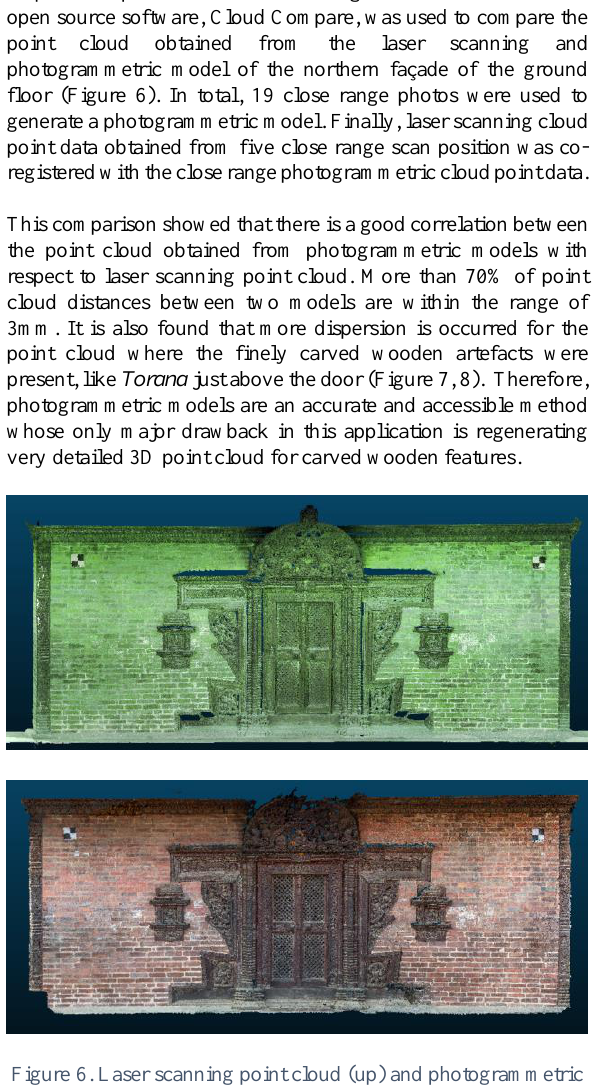
Figure 6. Laser scanning point cloud (up) and photogrammetric (bottom) point cloud